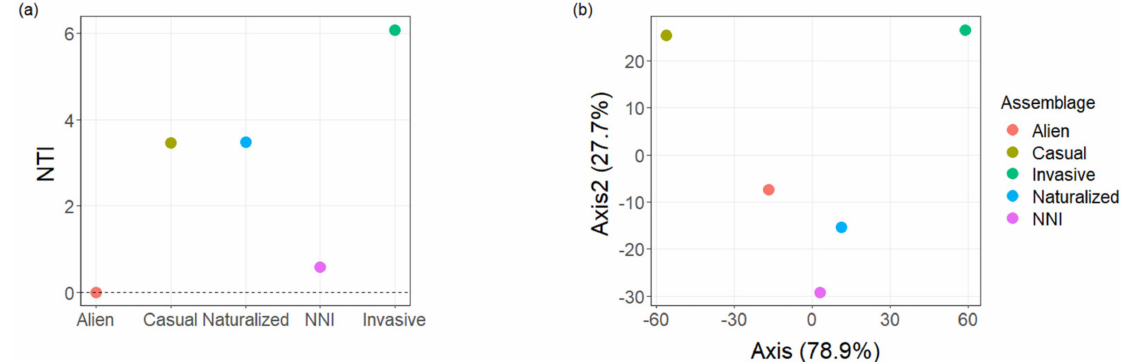
Figure 3. NTI values of different species assemblages: alien, casual aliens, naturalized, NNI (naturalized but not invasive) and invasive species ( a ); and MNTD values between these assemblages ( b ), visualized by PCoA